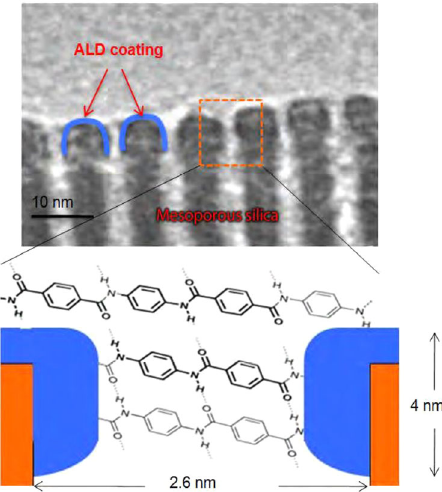
Fig. 10 Application of ALD in developing a membrane for water desalination. The top images show the transmission electron microscopy (TEM) of a modi fi ed pore geometry through ALD process, which are limited to the mouth of the pore, while the bottom image is a further modi fi cation of the internal pore geometry using the polypeptide groups through the ALD process resulting in pore active sites with dimensions and chemical functionality that are comparable to those seen in natural biological pores. (Susan Rempe et al. 2010 Sandia laboratory publication on Biomimetic membrane for water puri fi cation 2010) 140